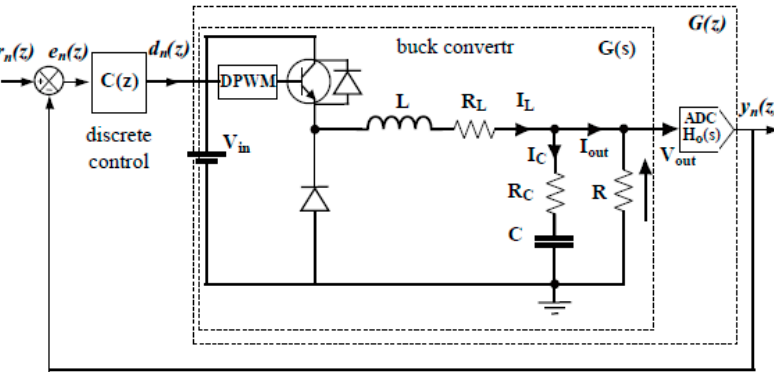
Figure 1. Switching DC-DC converter with digital voltage-mode control.